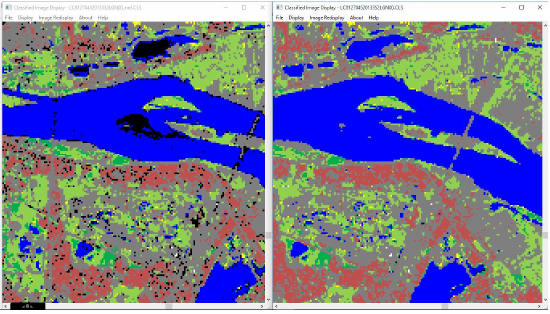
Figure 2. Classified image without filling of unknown pixels (left) and with filling of unknown pixels by spectral matching